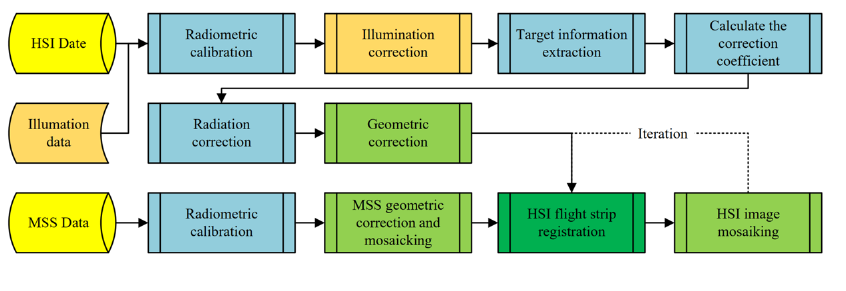
Figure 4. Data processing flow